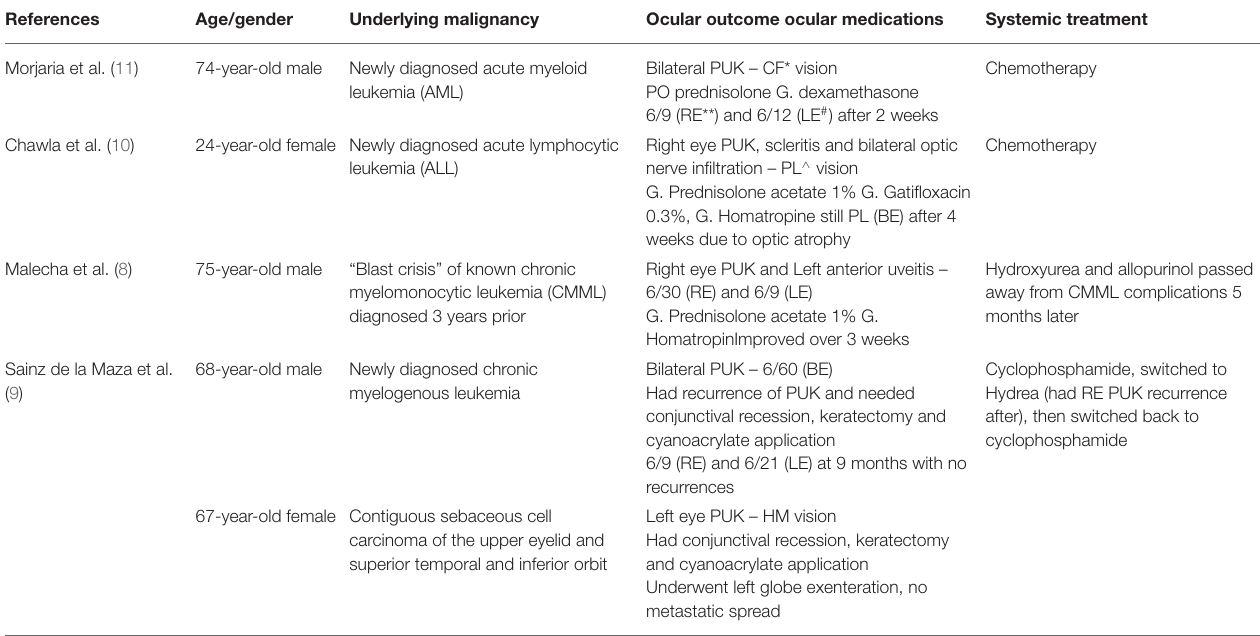
TABLE 1 | Literature review on PUK associated with other